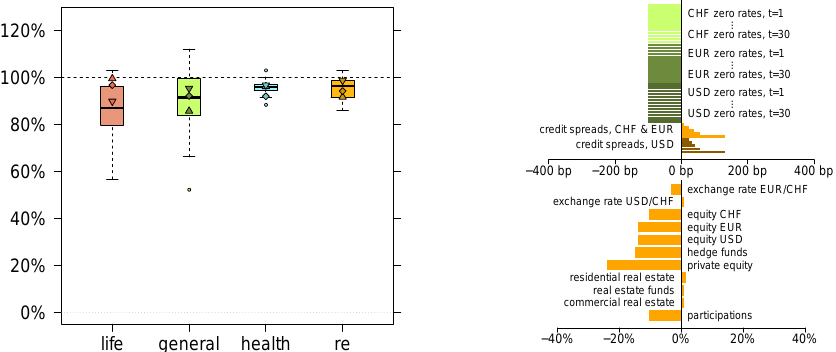
Figure 5. (rhs) illustrates the changes in market risk factors due to a decline in all zero-coupon rates. The changes colored green are predefined, the changes colored orange result from market dependencies. (lhs) illustrates the resulting impact ratios (cid:36) i of the insurance companies, where (cid:78) , (cid:7) and (cid:72) correspond to the impact ratios of the first, second and third largest company, respectively, in each branch of